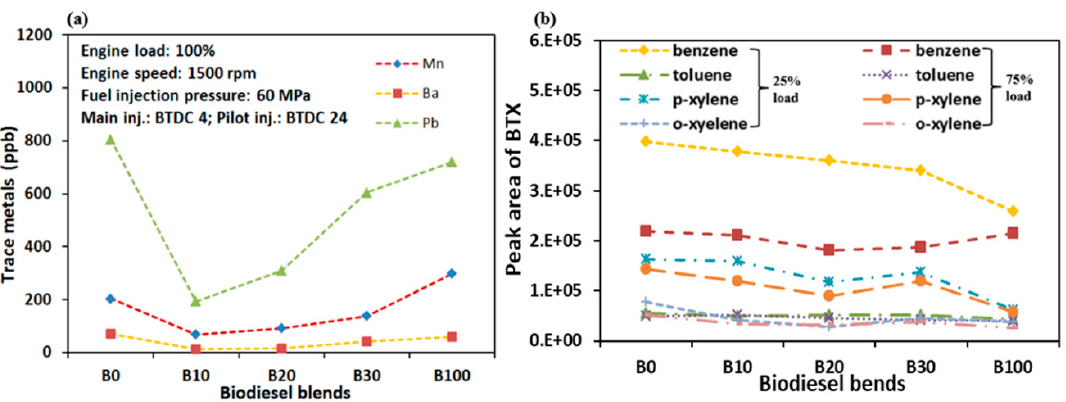
Figure 12. Trace metals ( a ) and peak area of benzene, toluene, and xylene (BTX) emissions ( b ) for all tested fuels.